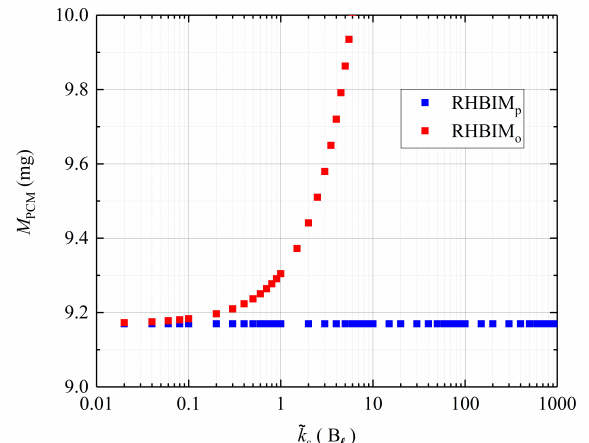
Figure 4. Total mass of the salt for solid melting fractions of f s = 0.999, according to the solutions from each model discussed in this work and obtained through the